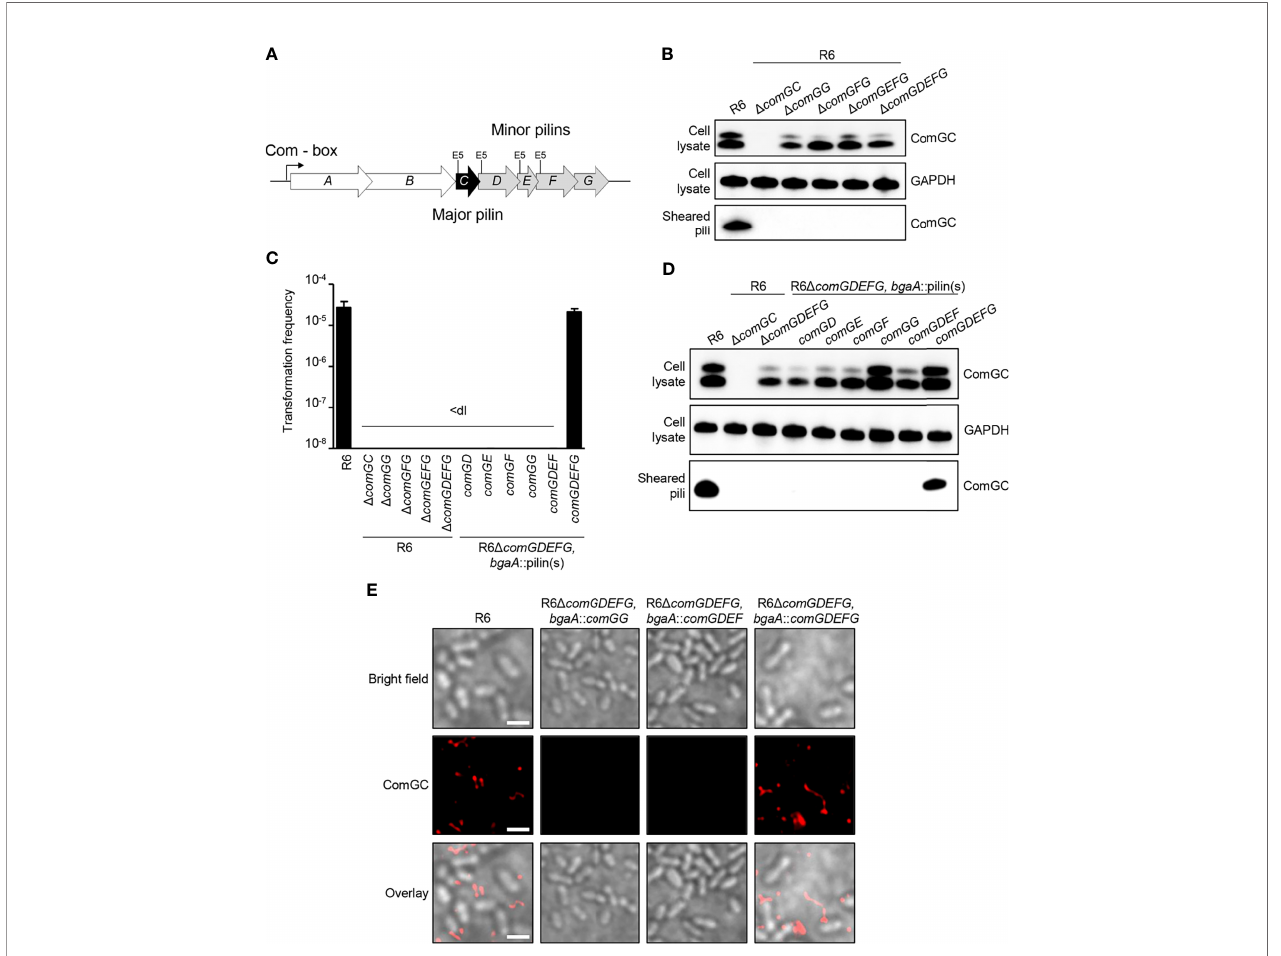
FIGURE 1 | Competence pilus assembly and transformability depends on the pneumococcal minor pilins. (A) Schematic representation of the comG operon in S. pneumoniae R6 strain encoding comGA and comGB (white), the major pilin gene comGC (black) and the minor pilin genes comGD, comGE, comGF and comGG (grey). The invariant Glu5 residue, present in all pneumococcal pilins except ComGG, is highlighted (E5). (B) ComGC was detected by immunoblotting in bacterial whole cell lysates and sheared pili of mutants lacking D comGC , D comGG , D comGFG , D comGEFG . The WT strain was included as a positive control and GAPDH as loading control. (C) Transformation frequency of WT , comG mutants and R6 D comGDEFG complemented strains. The detection limit (dl) of the assay was 2.39e -9 and the error bars represent the standard deviation of a minimum of three independent experiments (n=3). (D) Western blotting analysis of ComGC in bacterial whole cell lysates and sheared pili of D comGDEFG strains expressing individual minor pilins, comGDEF or comGDEFG at the ectopic bgaA locus. The WT strain was included as a positive control and GAPDH as loading control. (E) Immuno fl uorescence microscopy (IF) of competence-induced pili in WT R6 and R6 D comGDEFG complemented with comGG, comGDEF or comGDEFG. Bacteria were visualized by bright fi eld (BF) microscopy and competence pili were labelled with antisera speci fi c for ComGC (red). Scale bars represent 2